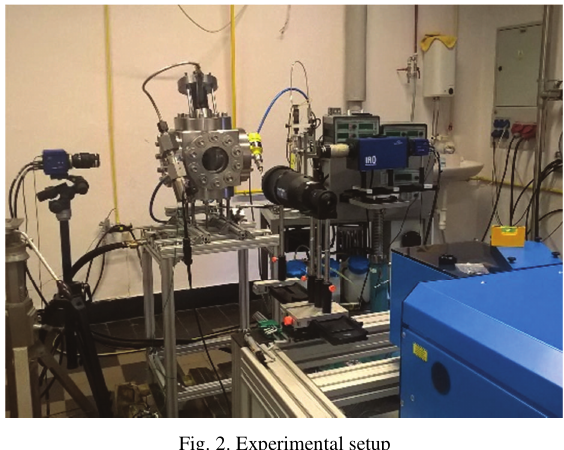
Fig. 2. Experimental setup